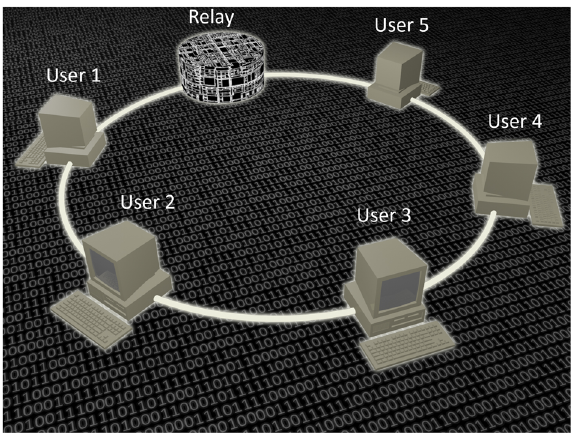
Fig. 1 Illustration of a Sagnac-loop-based twin- fi eld quantum key distribution (TFQKD) network. Multiple users can be placed on the same loop to communicate via a single relay. As can be seen here, arbitrary pairs of users can have very different distances (channel losses) from the relay, which necessitate a TFQKD protocol that maintains good performance even in the presence of channel asymmetry. In this work, we present the experimental implementa- tion of an asymmetric-intensity TFQKD protocol that maintains high rate through asymmetric channels, thus demonstrating the feasi- bility of such a Sagnac-loop-based TFQKD network.